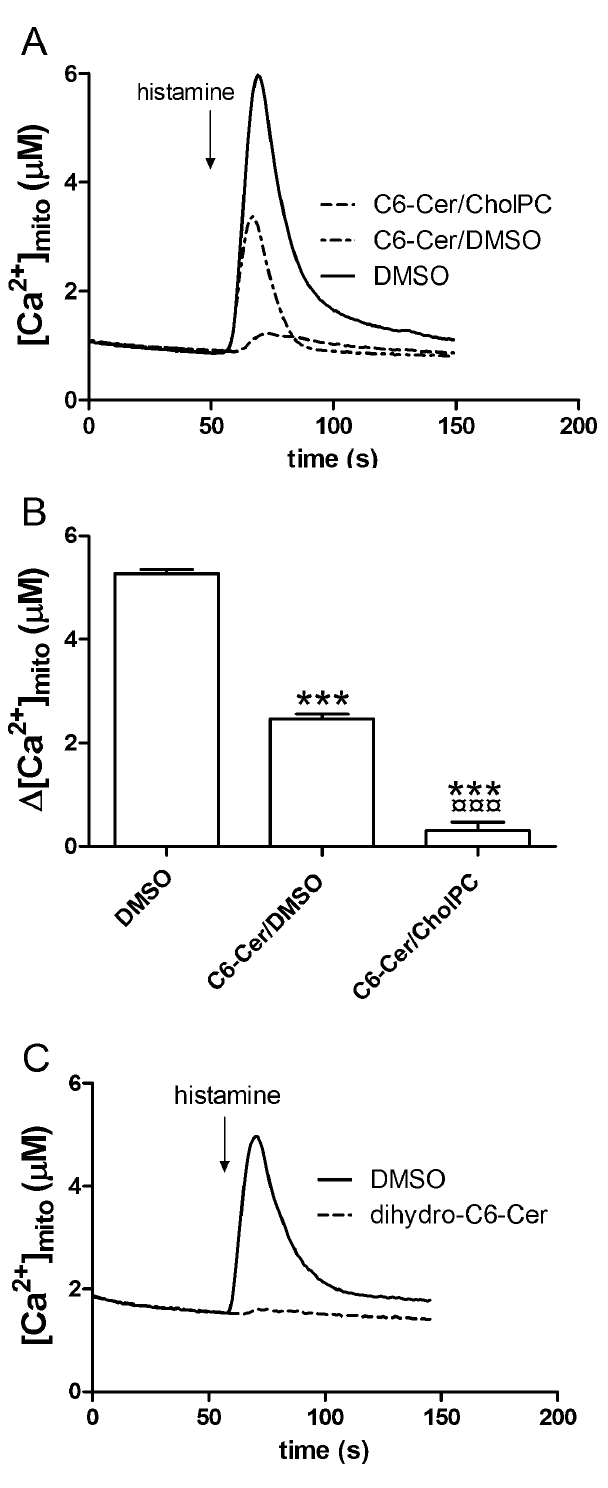
Figure 6. Induction of apoptosis in FRTL-5 cells by C6-Cer. A. The cells were exposed for 48 hrs to C6-Cer/CholPC or C6-Cer/DMSO (0.05 mM), and the fraction of apoptotic cells was measured. Each bar value is the mean 6 SEM of 3 different experiments. *p , 0.05, ***p , 0.001. B. Induction of apoptosis in FRTL-5 cells by Chol/Chol-PC. The cells were exposed for 48 hrs to Chol/Chol-PC (0.05 mM), and the fraction of apoptotic cells was measured. Each bar value is the mean 6 SEM of 3 different experiments (NS=no